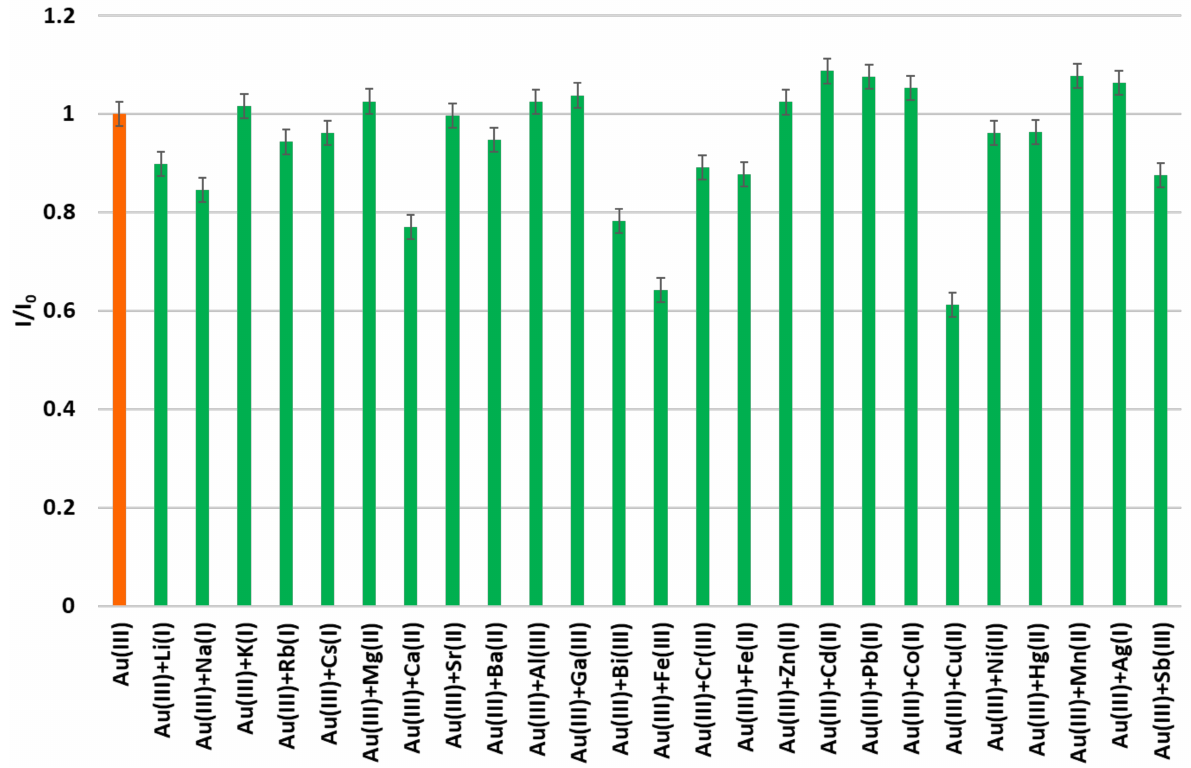
Figure 5. Fluorescence quenching of DHP-OH (10 µ M) in the presence of Au 3+ (10 µ M) and foreign metal ions (10 µ M) in Tris-HCl (pH 6.0).